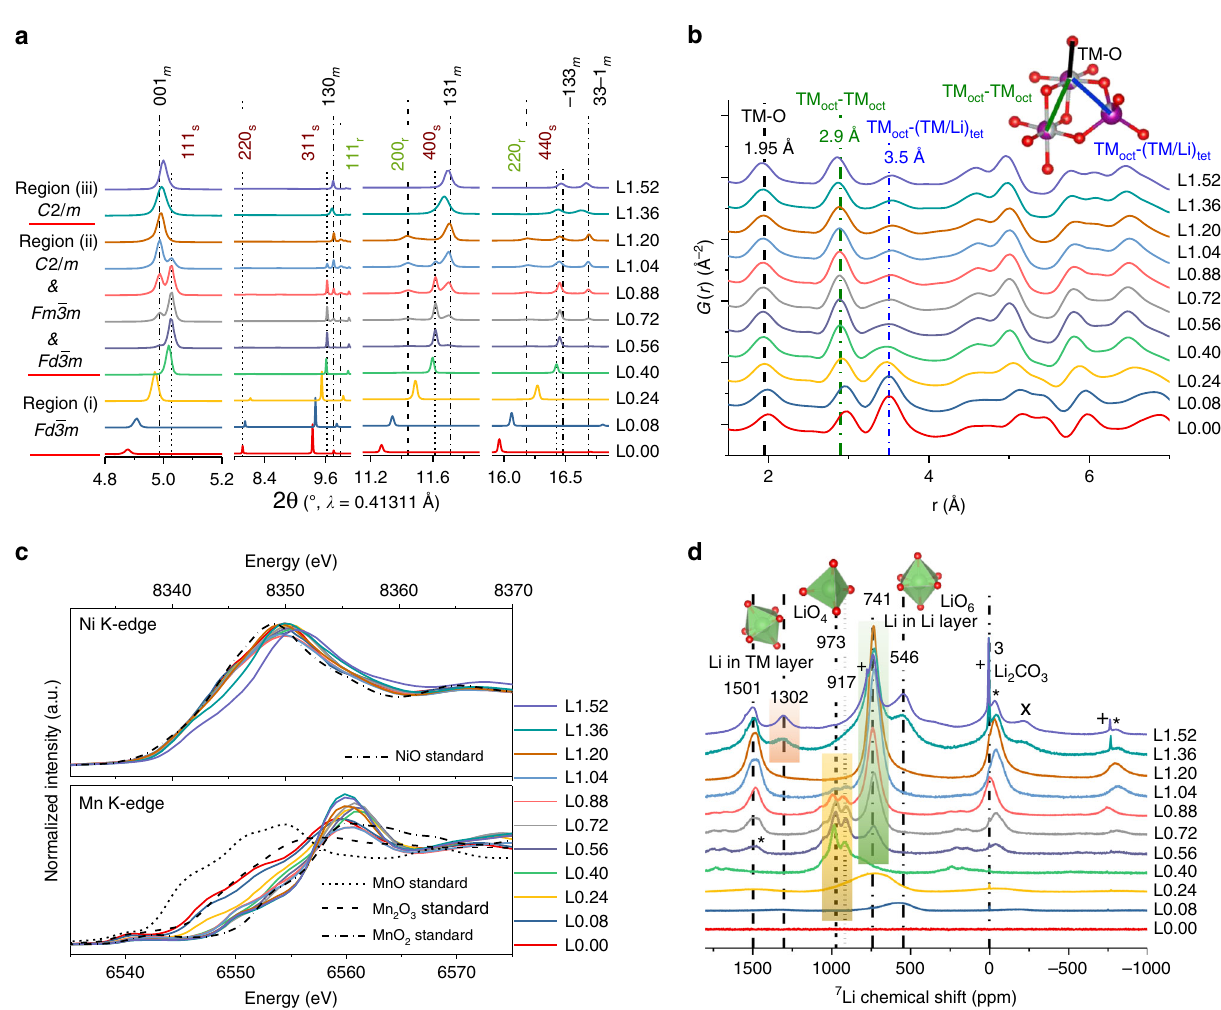
Fig. 1 Structural and electronic analysis of thermodynamically stable Li x Ni 0.2 Mn 0.6 O y oxides. a High-resolution SRD patterns, b PDF analysis, c Ni K-edge and Mn K-edge XAS spectra, and d 7 Li MAS-NMR spectra (spinning sidebands are marked with a plus, a cross and an asterisk) obtained after thermal treatment (850 °C for 12 h) of the precursor together with different amounts of Li 2 CO 3 (L0.00 to L1.52). For the diffraction patterns in Fig. 1a, Rietveld re fi nements were carried out to estimate the phase composition and lattice parameters of each product, m means layered monoclinic phase, r represents rock-salt-type phase and s means spinel phase. For PDF analysis in Fig. 1b, the fi rst peak at ~1.95 Å (black line) corresponds to the nearest TM-O coordination shell; the second peak at ~2.9 Å (green line) corresponds to the second neighbor coordination via oxygen of two TM ions both located on octahedral sites TM oct − TM oct , and the third peak at ~3.5 Å (blue line) to the second neighbor coordination via oxygen with one TM on an octahedral and the other TM or Li on a tetrahedral site TM oct − (TM/Li) tet , tet and oct means tetrahedral and octahedral sites, respectively. Each NMR spectrum in Fig. 1d is normalized with respect to the mass of the sample and the number of spectral